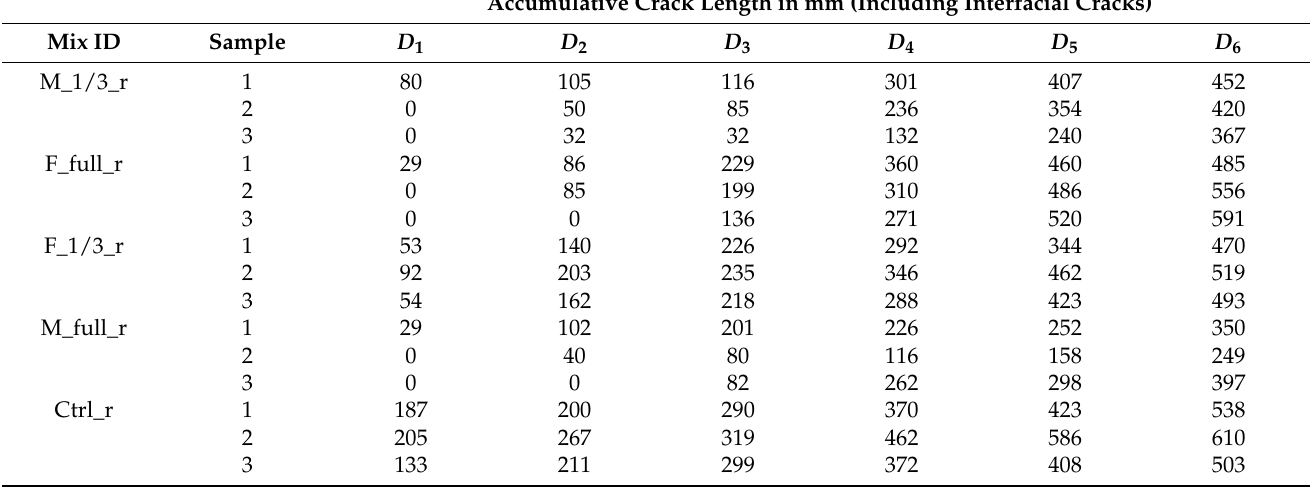
Table 5. Summary of crack length after repeated